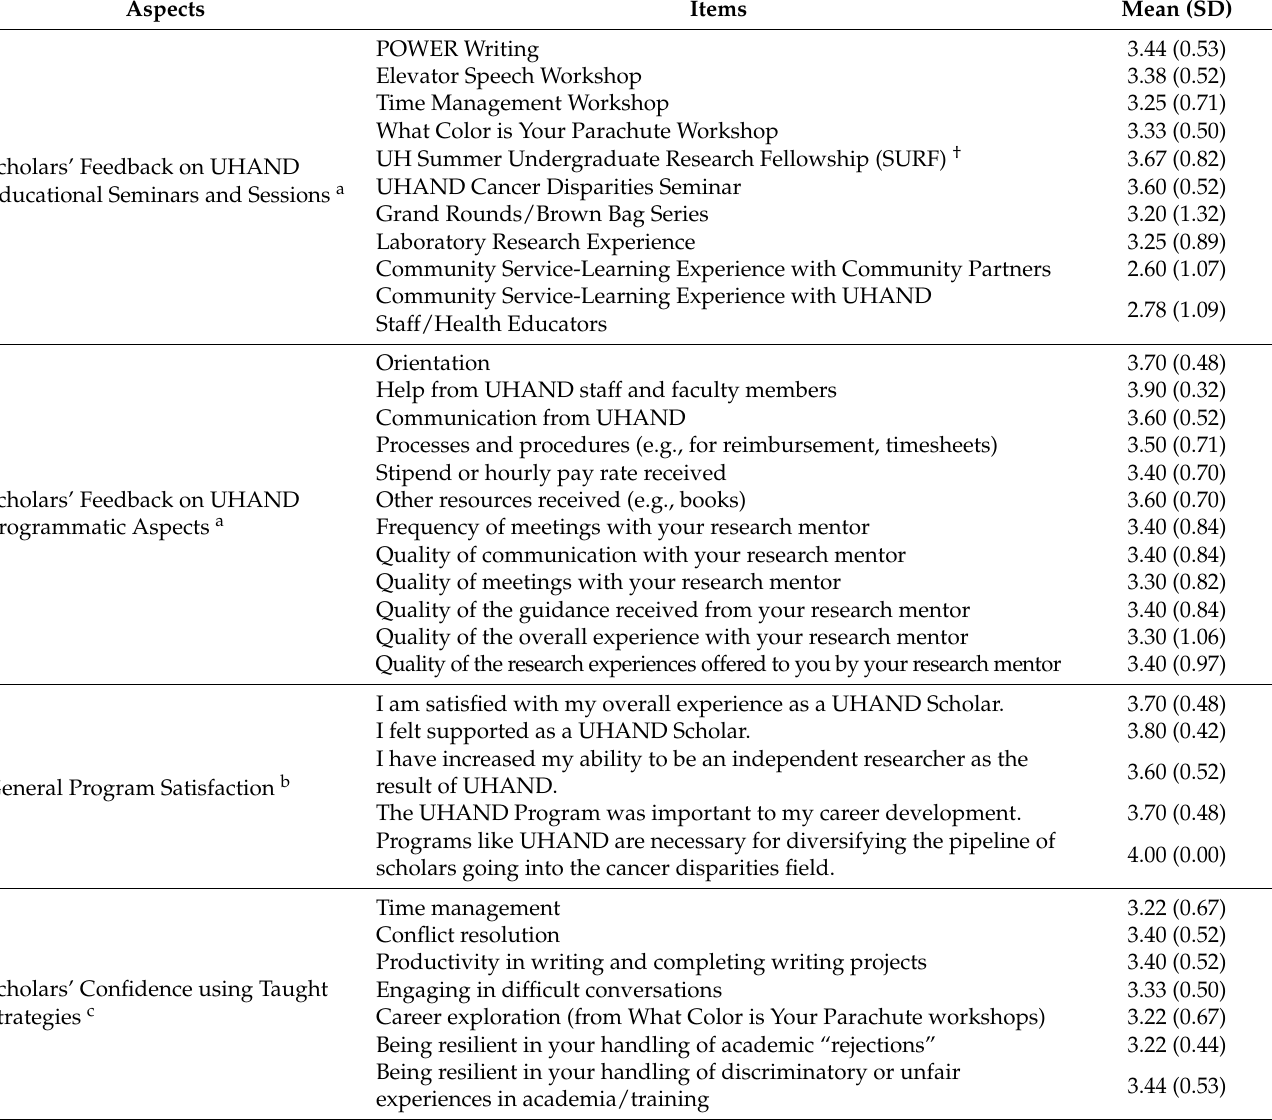
Table 5. UHAND Program Feedback and Strategies Learned from UHAND